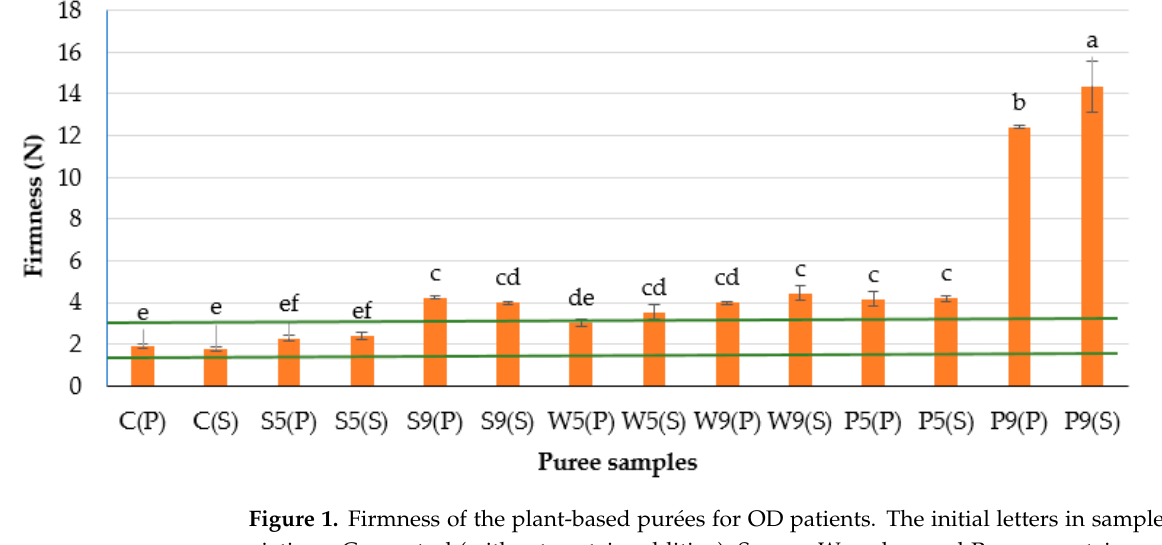
Figure 1. Firmness of the plant-based purées for OD patients. The initial letters in sample abbreviations, C—control (without protein additive), S—soy, W—whey and P—pea protein, represent the samples used in the formulations; the numbers represent the proportions of protein added (5 or 9 g/100 g); the letters in brackets represent the type of secondary treatment (P—pasteurization; S—sterilization). Horizontal lines indicate the target values. Different letters indicate significant differences between samples ( p ≤ 0.05).